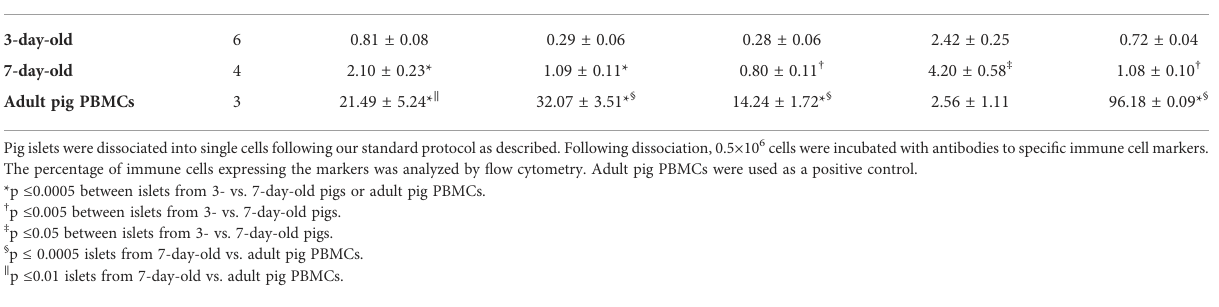
TABLE 4 Proportions of immune cells in islets from 3- and 7-day-old pigs. Group